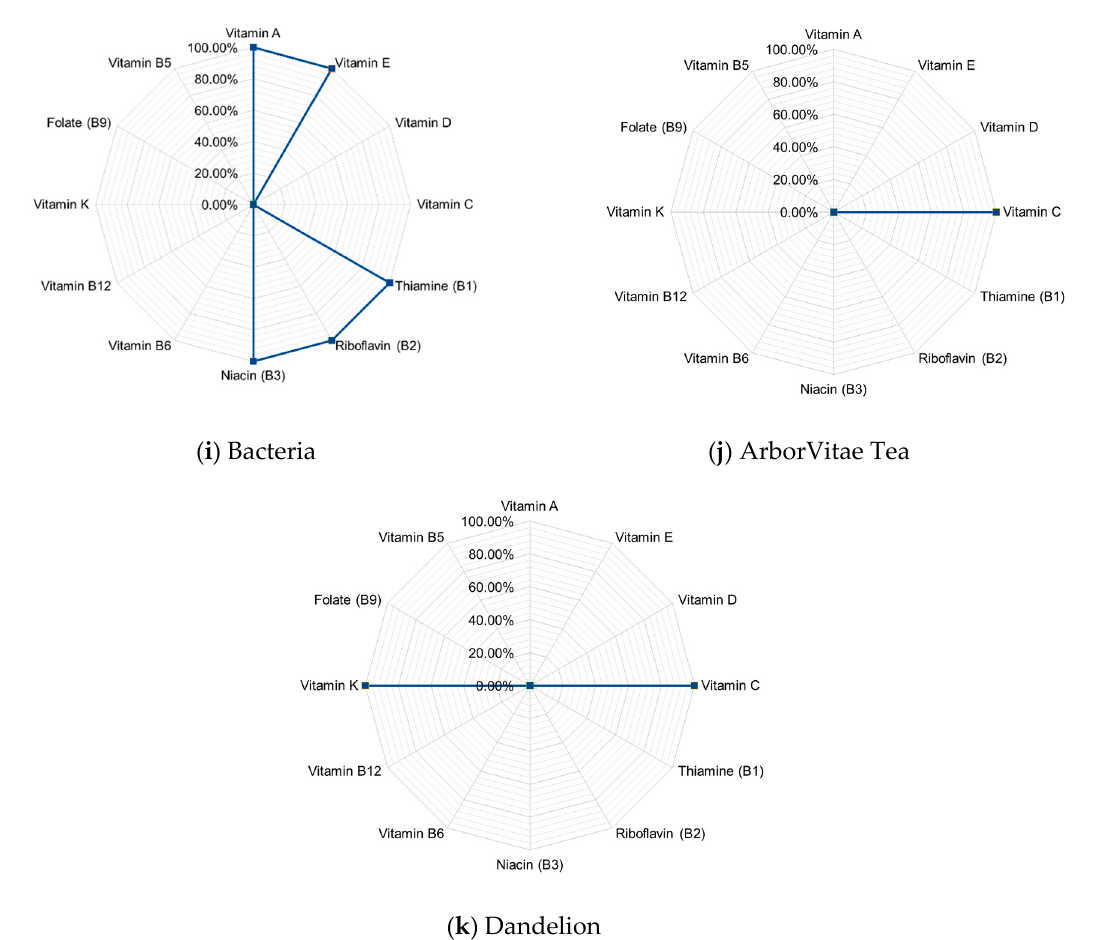
Figure 1. Micronutrients of 100% diet from single alternative food with US RDA percentages of vitamin A, E, D, C, B1, B2, B3, B6, B12, K, B9, and B5: ( a ) Tuna, ( b ) Beef, ( c ) Liver, ( d ) Chicken, ( e ) Shiitake mushrooms, ( f ) Oyster mushrooms, ( g ) Milk, ( h ) Eggs, ( i ) Bacteria, ( j ) ArborVitae tea, and ( k ) Dandelion. Please note that ArborVitae tea and dandelion did not have full nutrient profiles. Radial scale by 20% increments.